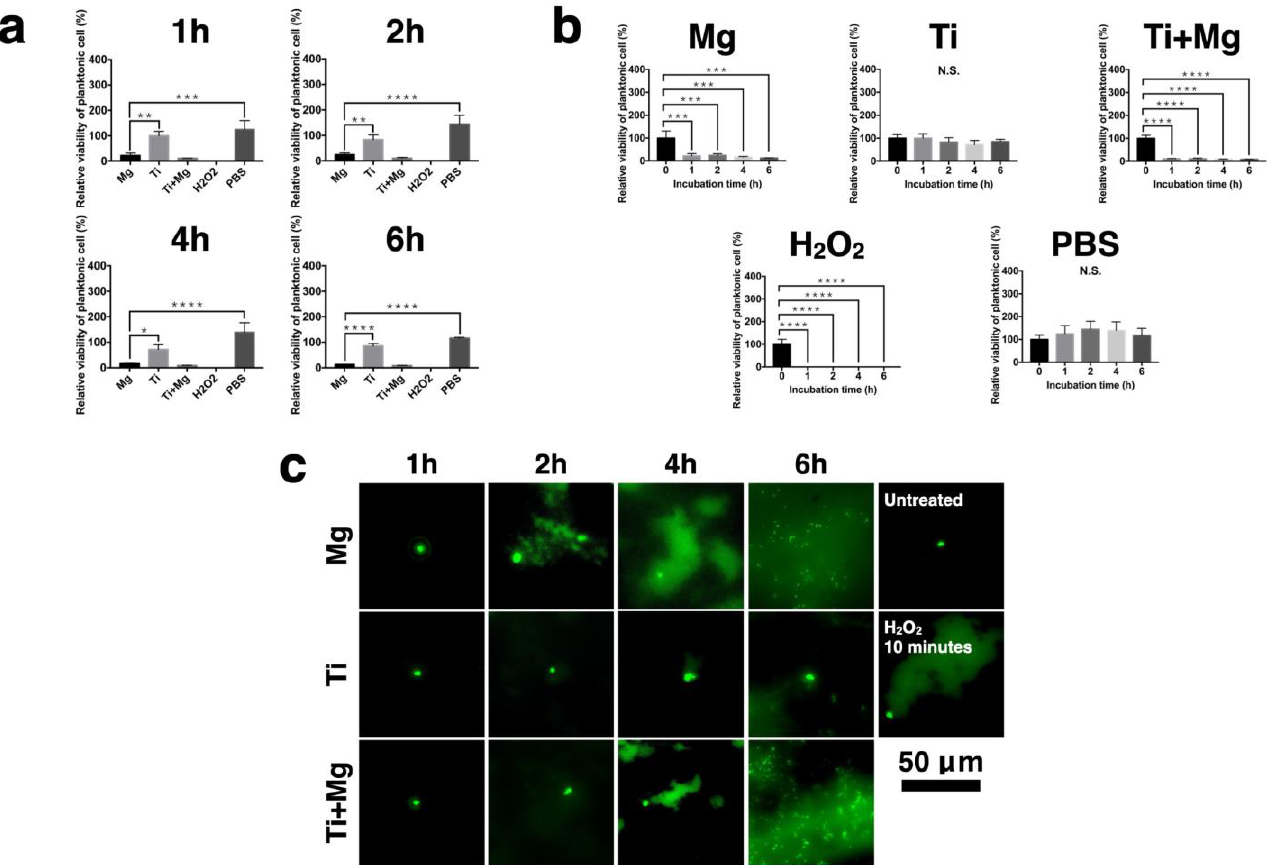
Figure 6. The viability of planktonic bacterial cell. ( a ) Bacterial cell viability qualification by MTT assay with respect to different periods of incubation; ( b ) bacterial cell viability qualification by MTT assay with respect to different groups; ( c ) comet assay of planktonic bacteria reflects the degree of DNA damage. ( n = 3 per group; N.S. no significant difference, * p < 0.05, ** p < 0.01, *** p < 0.005, and **** p < 0.001).